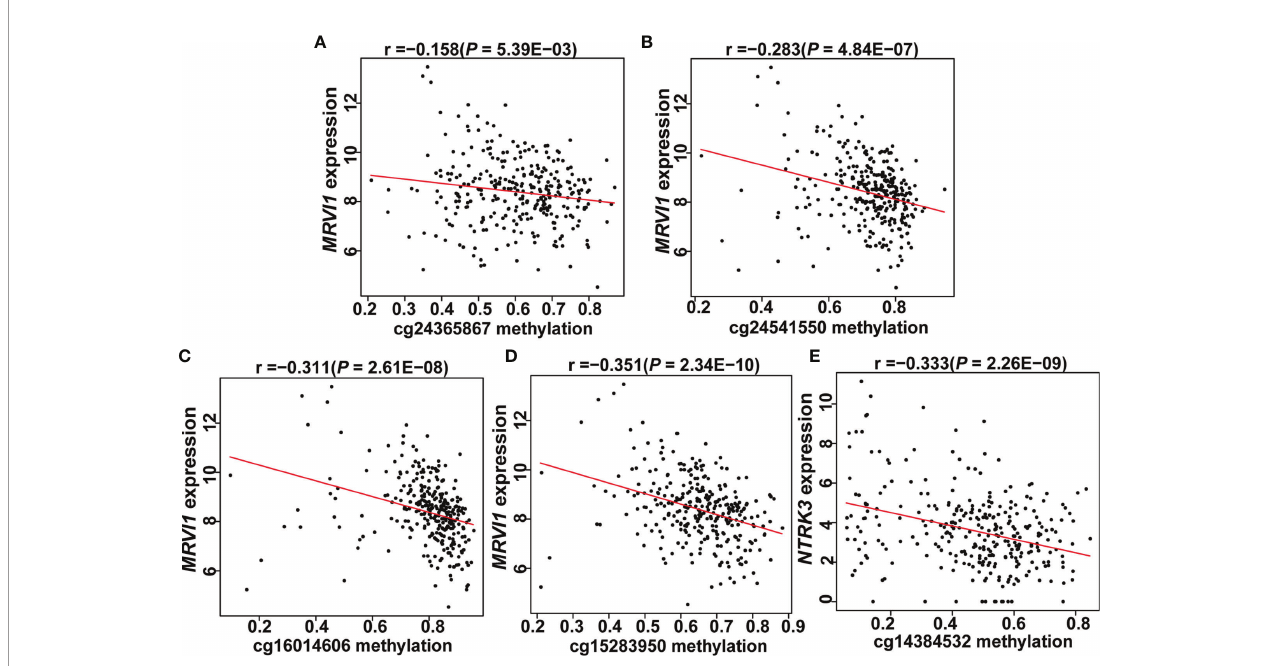
FIGURE 8 | Expression of two genes correlated with promoter CpG site methylation in cervical tissues. (A – D) MRVI1 gene expression was negatively correlated with DNA methylation levels of cg24365867, cg24541550, cg16014606, and cg15283950. (E) NTRK3 gene expression was negatively correlated with DNA methylation level of cg14384532. x-axis: DNA methylation levels; y-axis: relative gene expression levels; red line: linear regression.